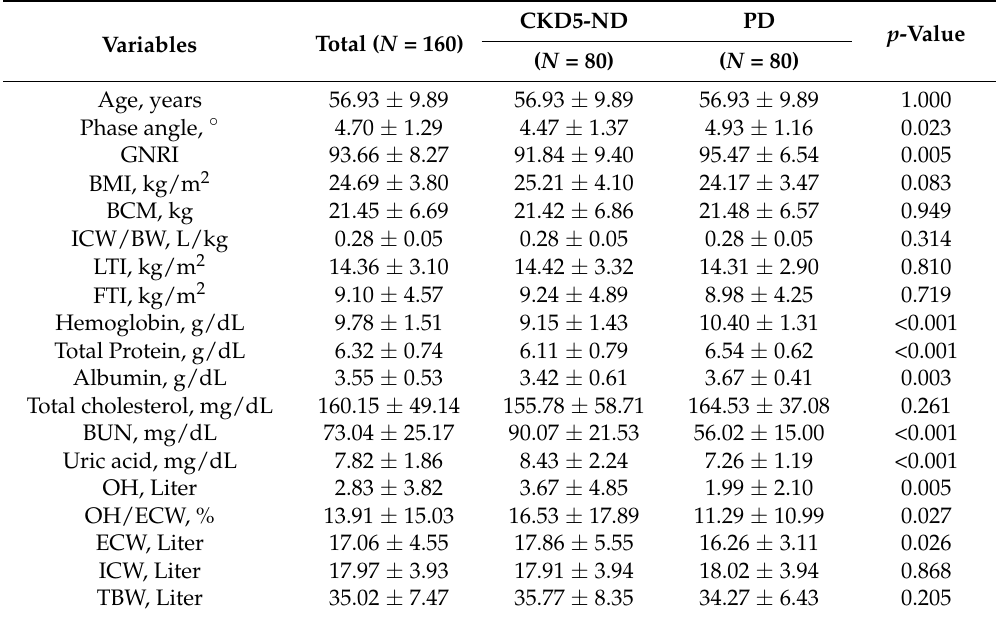
Table 1. Comparison of the CKD5-ND group and PD